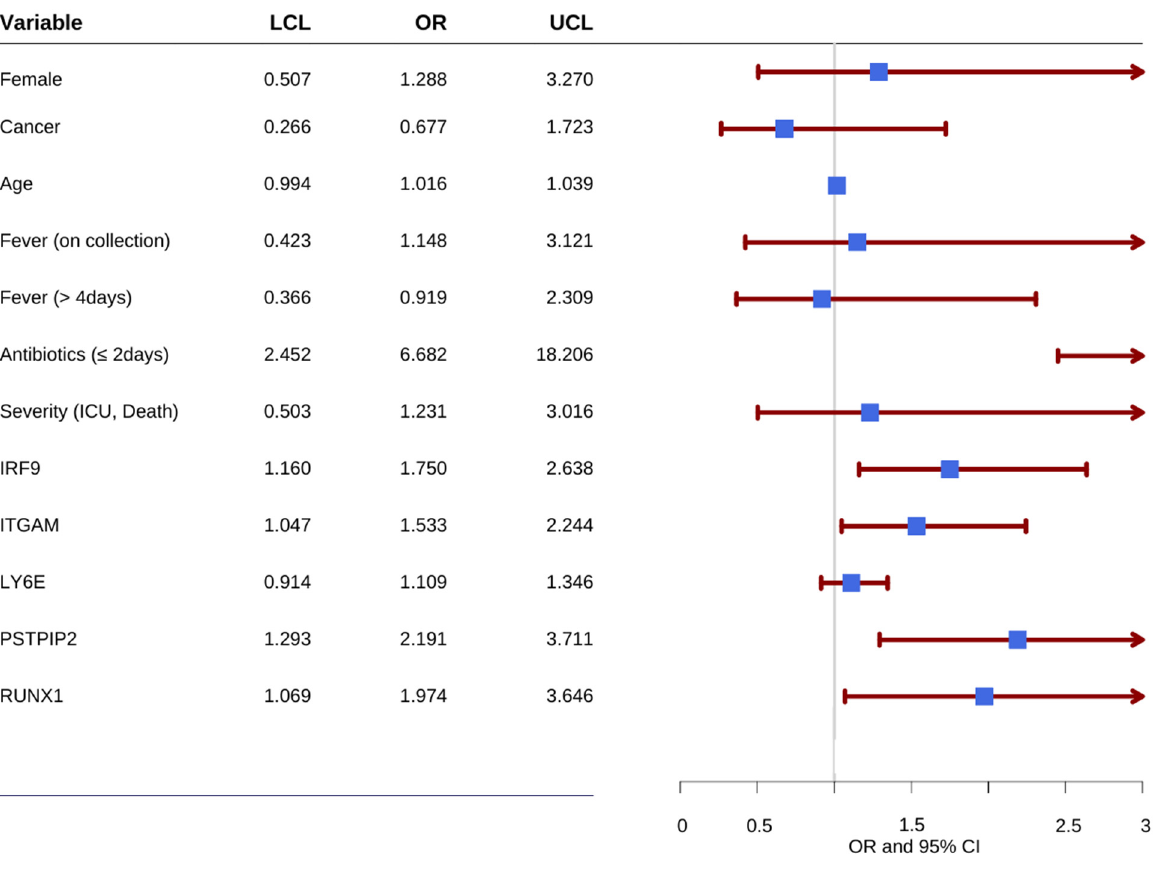
Figure 5. Forest plot presenting odds of FP. IRF-9 (OR = 1.750, 95% CI = 1.16 to 2.638), ITGAM (OR = 1.533, 95% CI = 1.047 to 2.244), PSTPIP2 (OR = 2.191, 95% CI = 1.293 to 3.711), and RUNX1 (OR = 1.974, 95% CI =